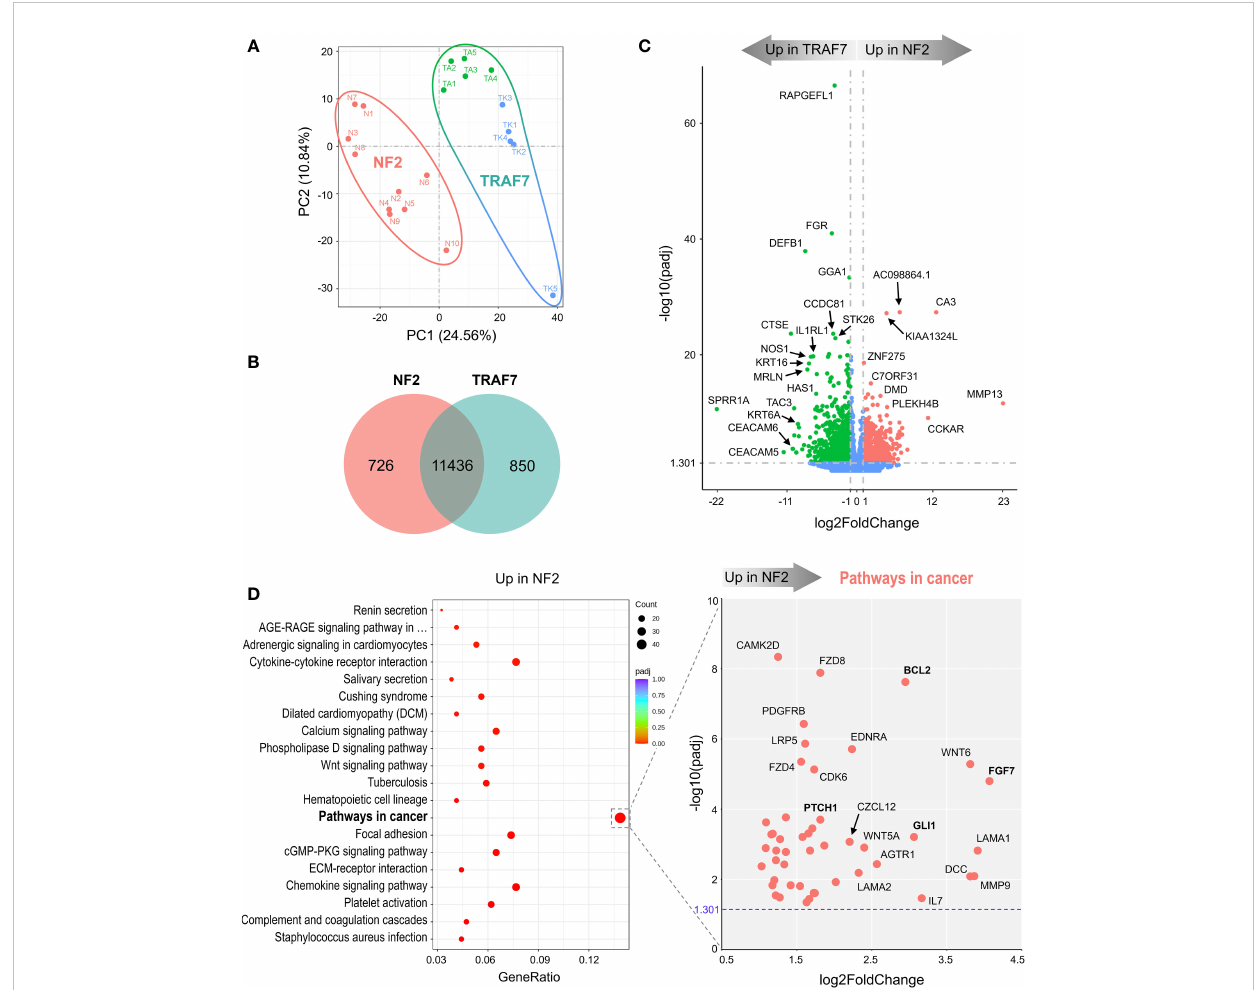
FIGURE 1 NF2 and TRAF7 meningiomas display divergent transcriptomes. (A) PCA plot of RNA-seq analysis in primary meningioma tumors carrying mutations in NF2 or TRAF7 . Ten samples were analyzed in each group and are shown in different colors. TRAF7 group of samples combines two subgroups of tumors carrying additional mutations in KLF4 (blue dots) or AKT1 (green dots). The sample clusters are circled by lines of corresponding colors. (B) Venn diagram showing genes expressed in NF2 and TRAF7 meningiomas. The numbers inside corresponding areas indicate the quantity of non- DEGs or genotype-speci fi c upregulated DEGs identi fi ed by RNA-seq. (C) Volcano plot visualizing signi fi cant DEGs in NF2 versus TRAF7 meningiomas: relative expression (x-axis) vs. statistical signi fi cance (y-axis) of difference in mRNA expression. Genes which are not differentially expressed are shown in blue. The directions of increasingly upregulated genes speci fi c for each group are shown by thick grey arrows above the chart with the corresponding tumor group name in it. DEGs with the highest discrepancy in relative expression between two groups are indicated. (D) Left panel: Bubble plot of KEGG enrichment analysis of signaling pathways upregulated in NF2 meningiomas versus TRAF7 tumors. Each bubble represents a KEGG pathway. Gene ratio (x-axis) is the propotion of the total genes in a given pathway that are upregulated in the indicated group. Right panel: Scatter plot of genes from the “ Pathways in cancer ” list. Genes shown in bold are of particular